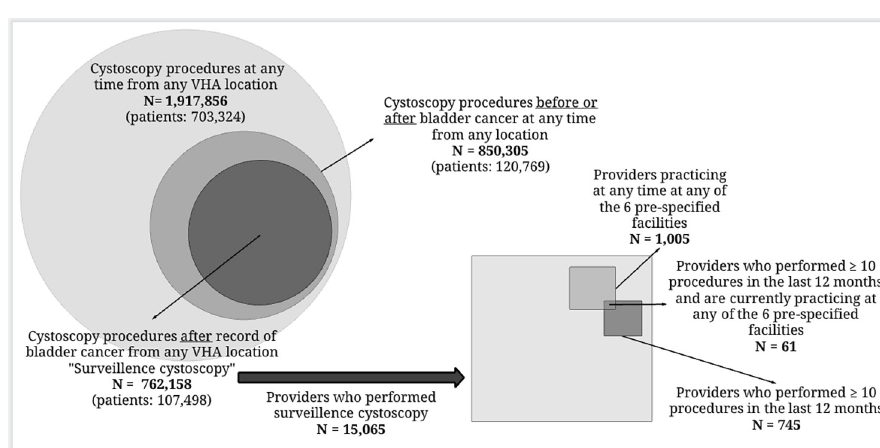
Fig 2. Pictogram describing the stepwise descent from patient data to the final list of eligible providers who performed qualifying surveillance cystoscopy.